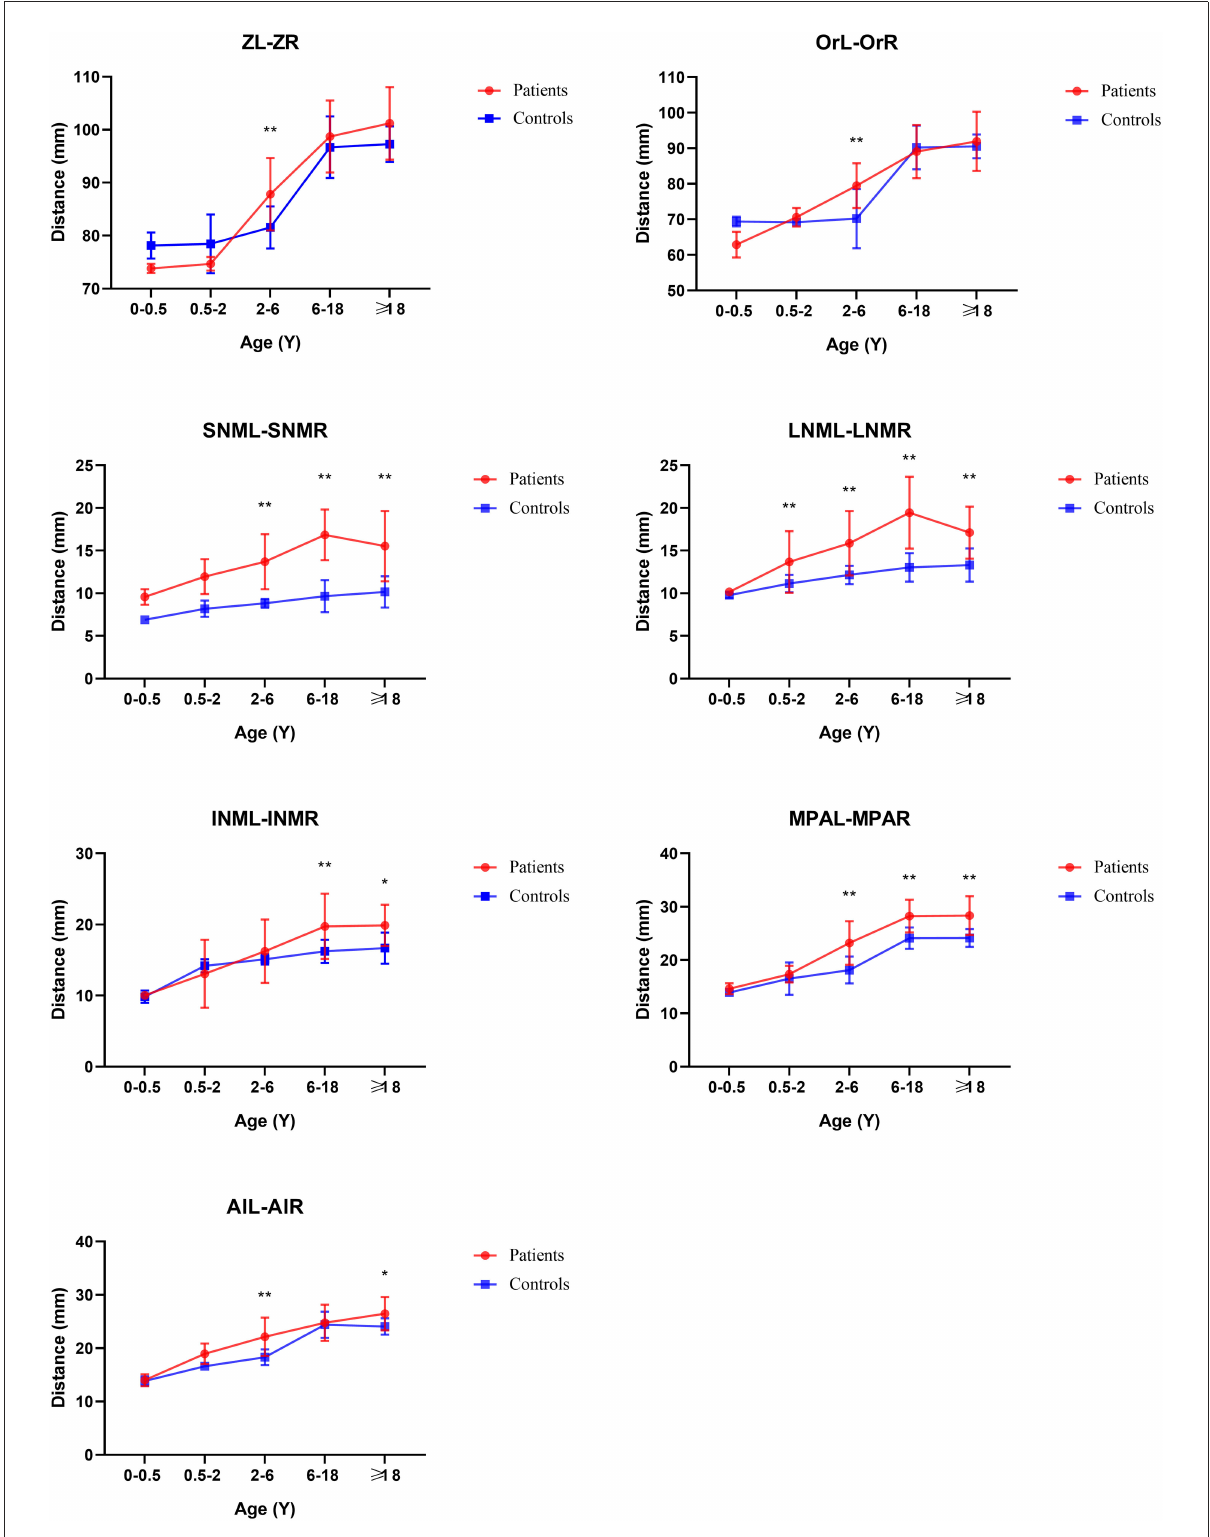
FIGURE3 Coronal view of face linear measurements by subgroup analysis. * P < 0.05; ** P <